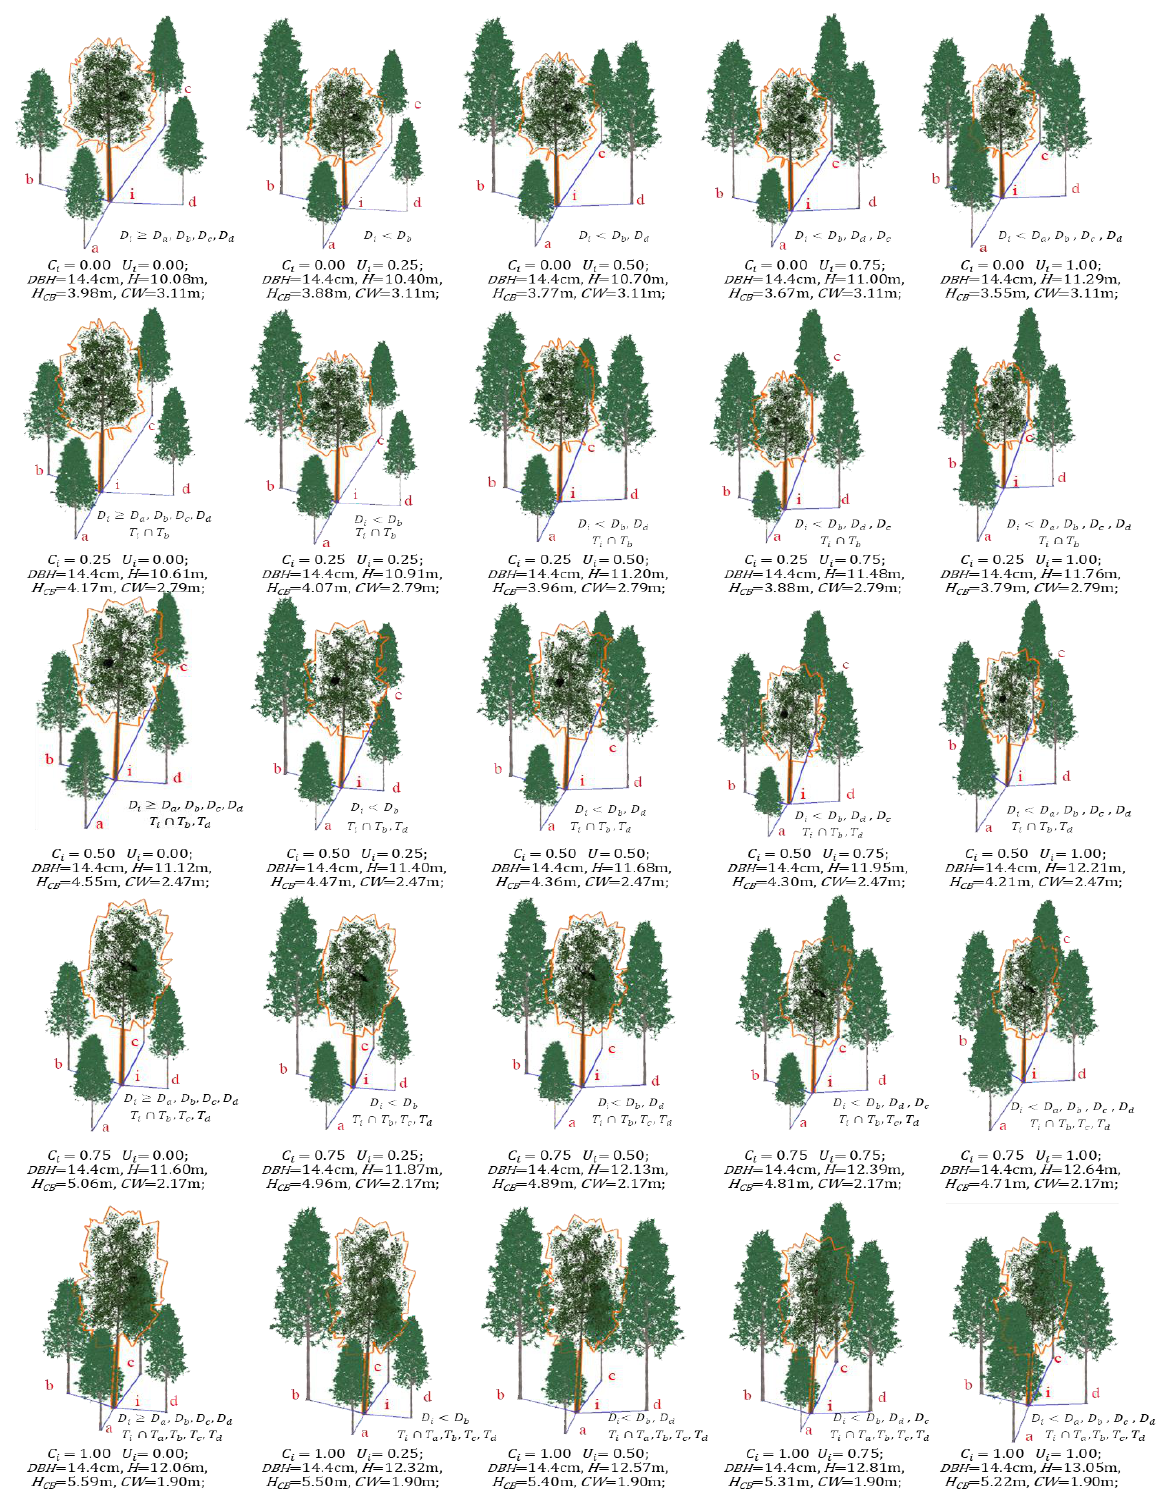
Figure A2. Three-dimensional modeling of BHN under different 𝐶 𝑖 and 𝑈 𝑖 . Notes: D i < D a ,D b ,D c ,D d indicated that the diameter of tree i was smaller than tree a, b, c, and d; T i ∩ T a , T b , T c , T d indicated that the canopy of tree i and tree a, b, c, and d overlapped; 𝐶 𝑖 and 𝑈 𝑖 had values of 0.00, 0.25, 0.50, 0.75, and 1.00. Since Machilus pauhoi (BHN) ( DBH = 14.4 cm) occurred most frequently in the study region, we chose it as an example.